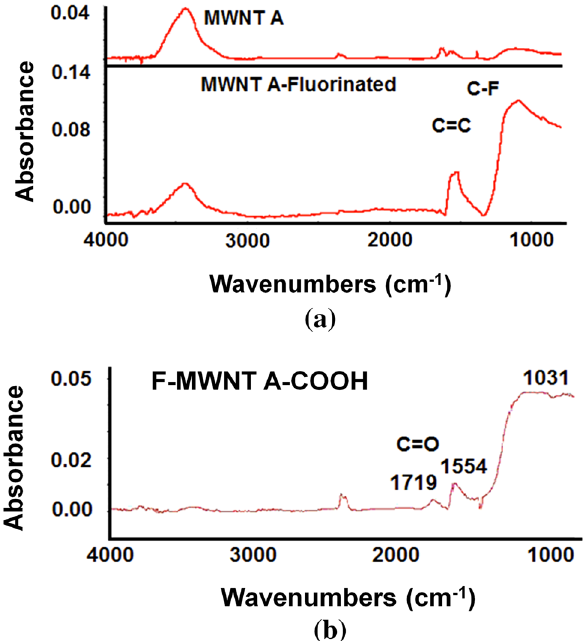
Fig. 3 FTIR spectra for MWNTs, MWNT A a before and after fluorina- tion and b after ethyl carboxylation